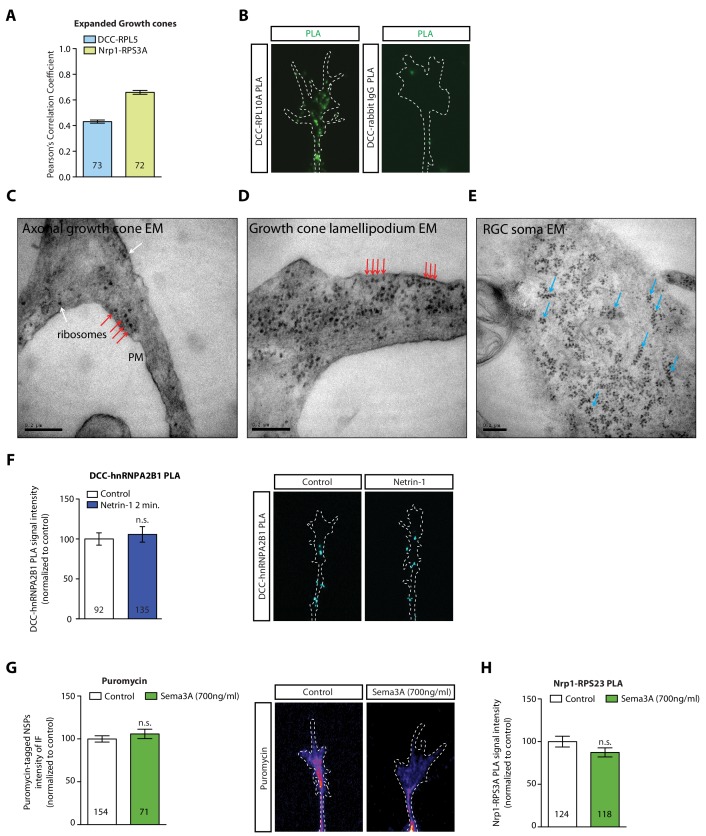
DCC and Nrp1 are in close proximity to ribosomes in axonal growth cones in a cue-dependent manner.(A) Pearson’s Correlation coefficients of DCC-RPL5/uL18 and Nrp1-RPS3A/eS1 from expanded axonal growth cones (data obtained from four biological replicates, bars indicate mean, error bars indicate SEM). (B) PLA images showing DCC and RPL10A/uL1 are in close proximity in axonal growth cones, whereas DCC and IgG control generates little to no PLA signal. Scale bars, 5 μm. (C–E) EM images of an unstimulated axonal growth cone (C), a growth cone lamellipodium (D) and a retinal ganglion cell body (E). Ribosomes can be seen aligned in rows (red arrows) or isolated (white arrow) under the plasma membrane and as polysomes (blue arrows) in the cell body. (F) PLA signal between DCC and hnRNPA2B1 does not decrease after a 2 min Netrin-1 stimulation in axonal growth cones (Mann-Whitney test; bars indicate mean, error bars indicate SEM; p=0.2886; representative PLA images are shown). (G) Sema3A stimulation at protein-synthesis independent concentration does not decrease puromycin levels in axonal growth cones (Mann-Whitney test; bars indicate mean, error bars indicate SEM; p=0.2487; representative images are shown) or (H) PLA signal between Nrp1 and RPS3A/eS1 (Mann-Whitney test; bars indicate mean, error bars indicate SEM; p=0.2555). For all Expansion microscopy, PLA and QIF experiments, numbers in bars indicate amount of growth cones quantified collected from at least three independent experiments.Figure 3—figure supplement 1—source data 1.Spreadsheet containing all Pearson’s correlation values for each expanded growth cone in Figure 3—figure supplement 1A, all normalized PLA count values for each axonal growth cone in Figure 3—figure supplement 1F and H, and all normalized puromycin intensity values for each axonal growth cone in Figure 3—figure supplement 1G.